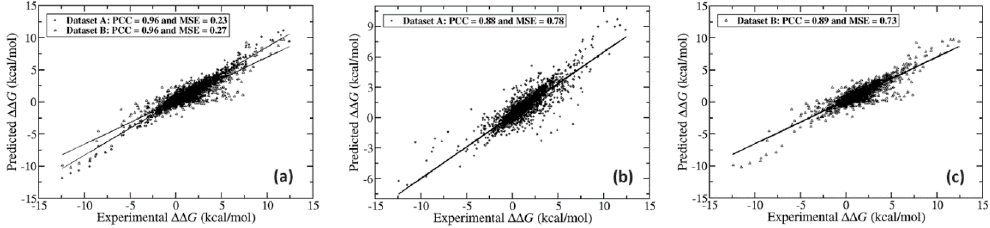
Figure 3. Correlation between predicted and experimental ΔΔ G over single mutations on ( a ) both dataset A and B using SAAMBE-3D ( b ) dataset A using mCSM-PPI2 and ( c ) dataset B using